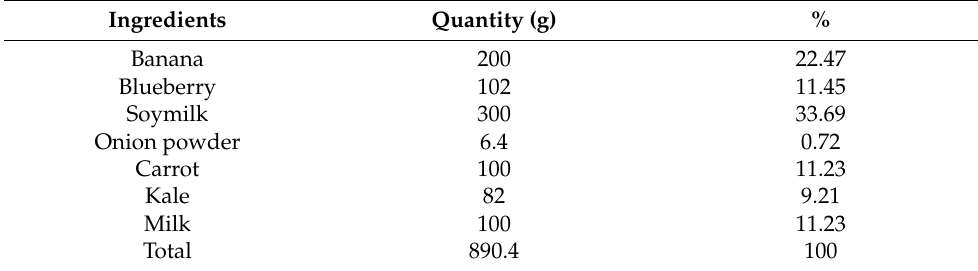
Table 1. The recipe of soymilk-based banana-blueberry-puree.